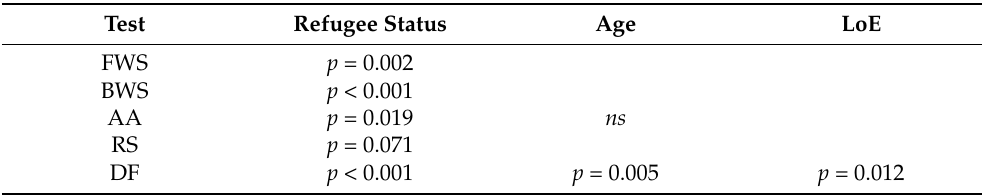
Table 1. Summary of the predictors involved in best fit models assessing the role of refugee status and individual variables on executive functions.